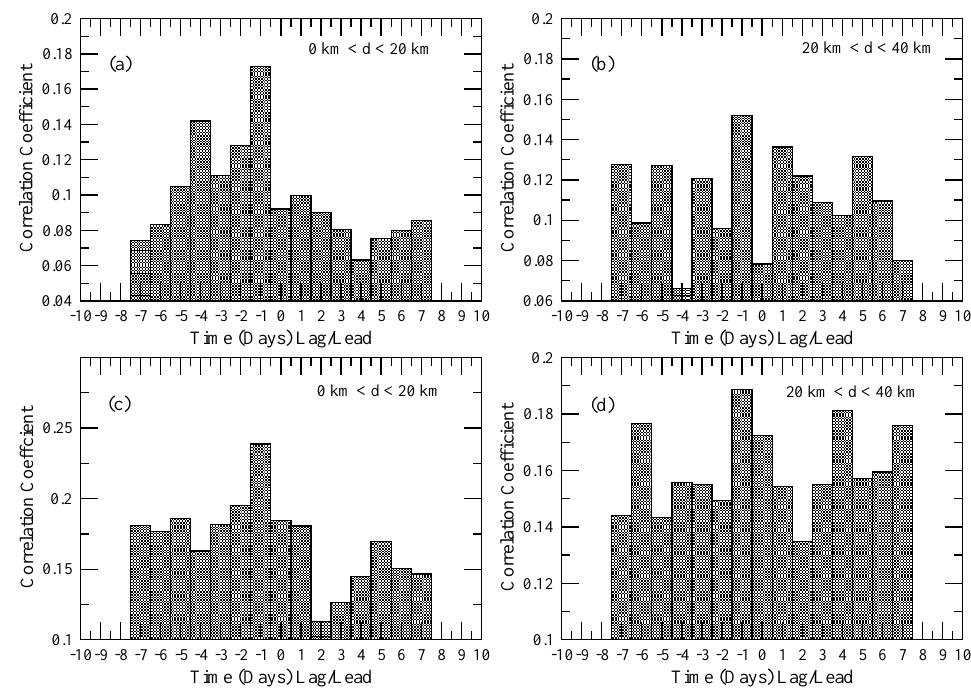
Fig. 8. The cross-correlations between the DLPT (a–b) or DLDT (c–d) with the effective earthquake magnitudes as a function of days before and after the event (“0”th day). (a) and (c) show the results for the earthquakes for which the depths ( d ) of the epicenter are less than 20km and (b) and (d) show the results of the earthquakes having depths of the epicenters between 20 and 40km. In all the cases, the peak occurs 1day prior to the seismic event. For the shallow earthquakes ( d < 20km) the peak is sharper and there are no other strong peaks before and after the event. For the deeper earthquakes (20 <d < 40) there are smaller peaks at other days also.